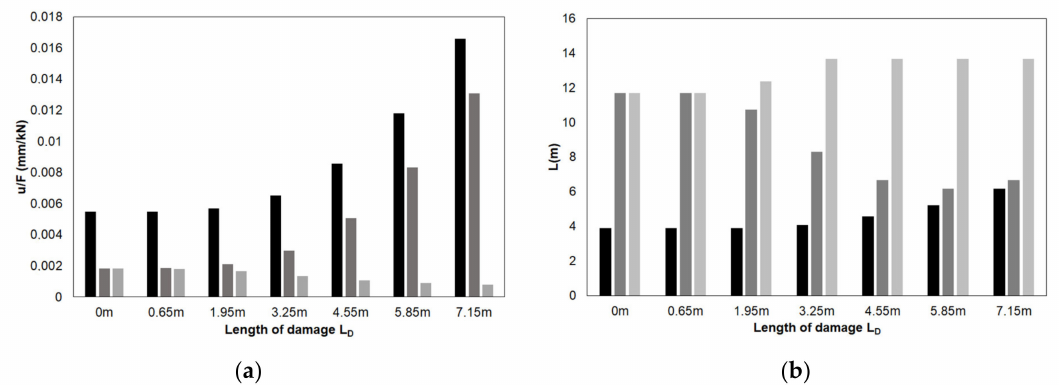
Figure 11. Calculated displacements of the rail (black), track plate/sleeper (mid grey), and base layer (light grey) for a slab track on a soil of v S = 200 m/s under an axle load of F T = 100 kN (FEBEM): ( a ) maximum displacements and ( b ) widths of displacements for track plate damages of different lengths L D